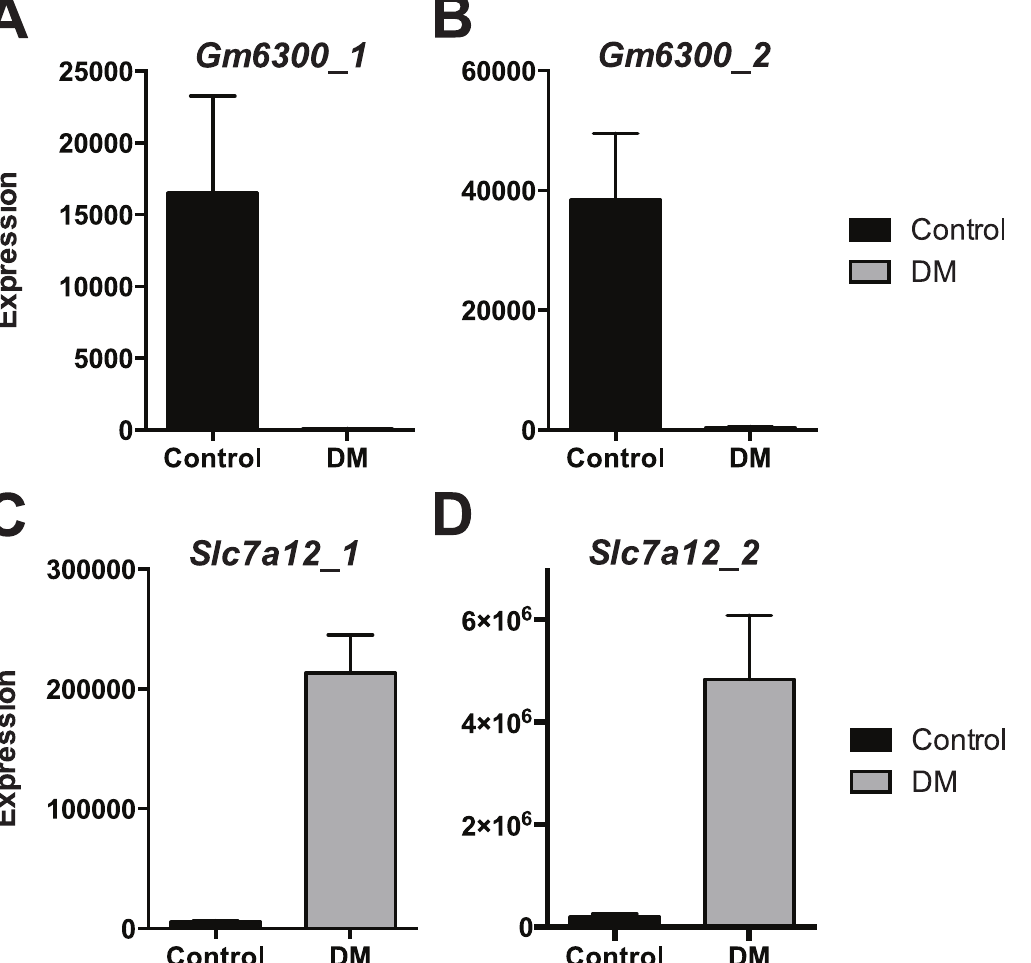
Figure 6. Differential expression of Gm6300 and Slc7a12 under control and diabetic conditions. Real-time PCR-based mRNA expression level (relative to 18S internal control) of Gm6300 ( A, B ) and Slc7a12 ( C, D ) using each of two different primer/probe sets per gene, and interrogating different putative expressed exons separated by an intervening intron. Intron-spanning amplicons are mapped in Figure 5. Probe sets (Invitrogen) were as follows: Gm6300_1 , Mm03949676_m1; Gm6300_2 , Mm03949677_m1; Slc7a12_1 , Mm00499866_m1; Slc7a12_2 , Mm01283157_m1. Data are expressed as mean + / 2 SEM for n=3–5 biological replicates, with 2 technical replicates per sample (i.e., individual samples assayed in duplicate). Consistent with RNA-Seq data, expression of Gm6300 was reduced by 99.5% ( A ) or 99% ( B ), whereas expression of Slc7a12 was increased 39-fold ( C ) or 27-fold ( D ) with diabetes, depending upon probe set.